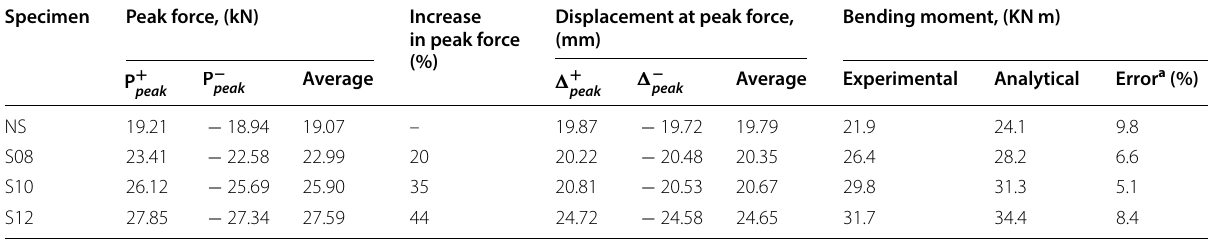
Table 3 Lateral load–displacement